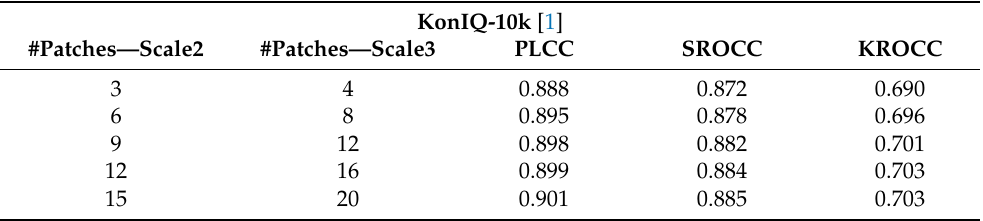
Table 5. Performance comparison on the effect of image patches’ number on KonIQ-10k [1]. Median PLCC, SROCC, and KROCC values were measured over 100 random train–test